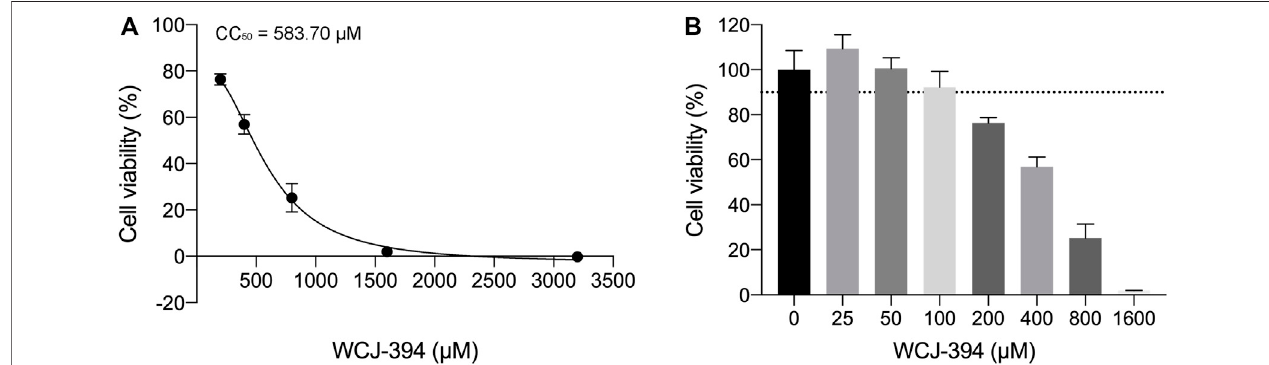
FIGURE 4| Potential cytotoxic effect ofWCJ-394 on A549 cells. (A) Cell viability ofA549 treated with WCJ-394, CC 50 = 583.70 μ M. (B) Effectof WCJ-394 on the A549 cell viability.